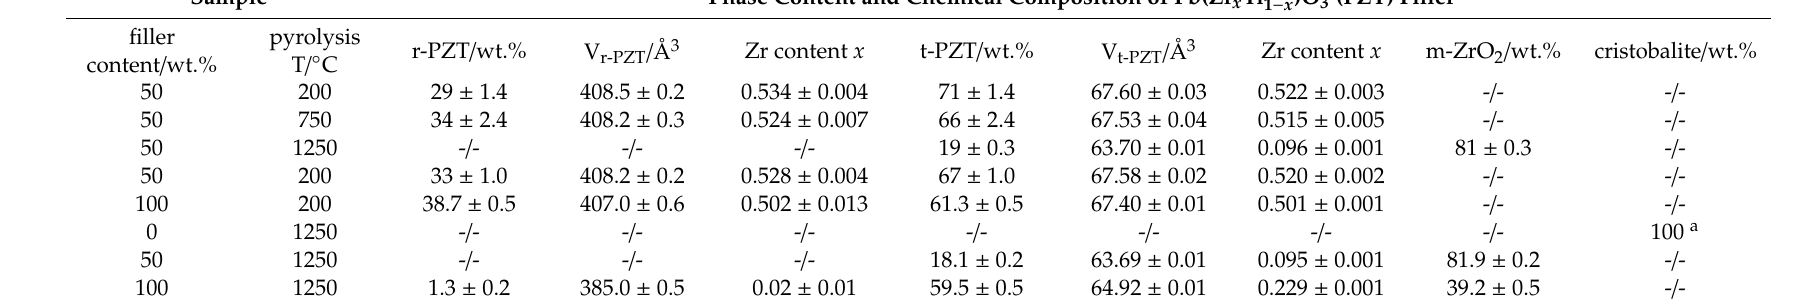
Table 1. Phase composition and chemical composition of the individual PZT fillers for selected PZT-polymer and PZT-SiOC composites (r-PZT: